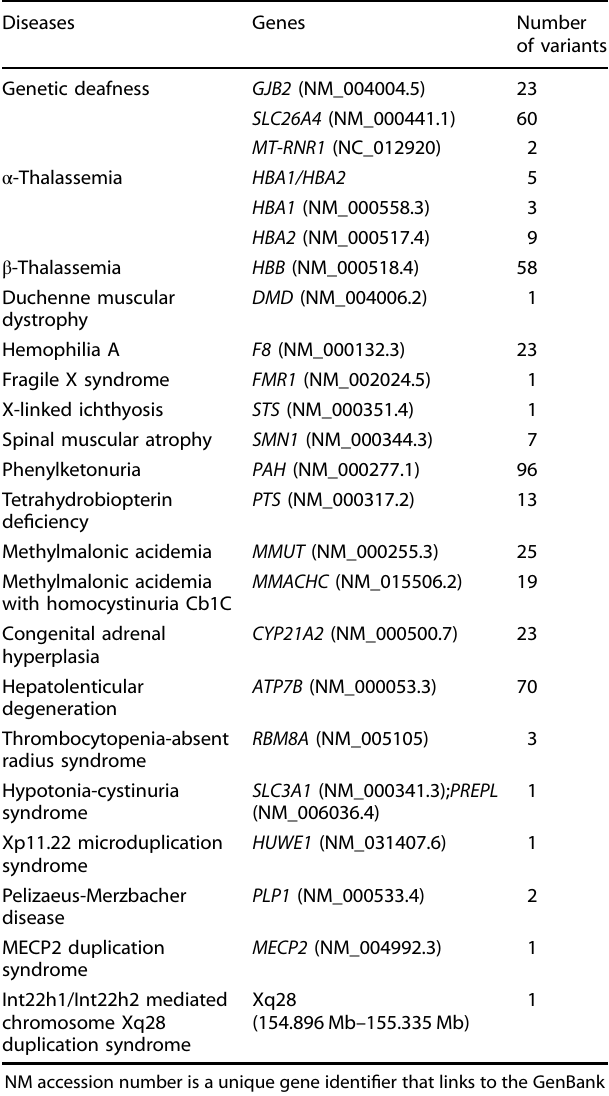
Table 4. The gene list and number of variants detected by